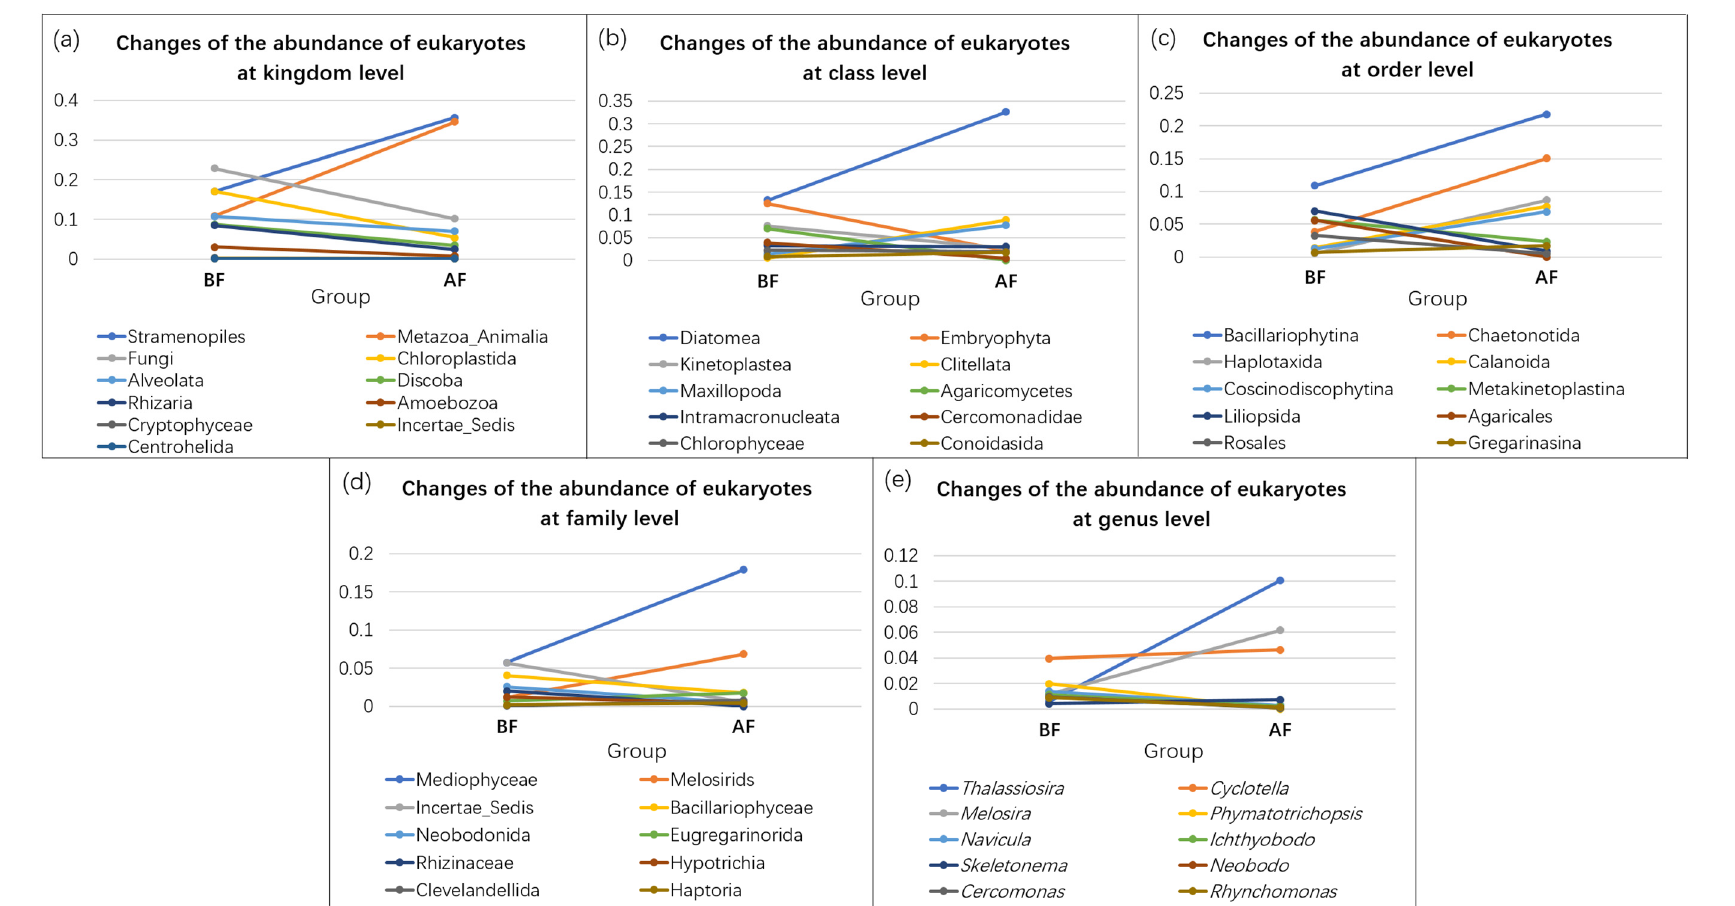
Figure 3. Changes in the relative abundance of eukaryotes before and after the floods at the kingdom level ( a ), class level ( b ), order level ( c ), family level ( d ), and genus level ( e ).